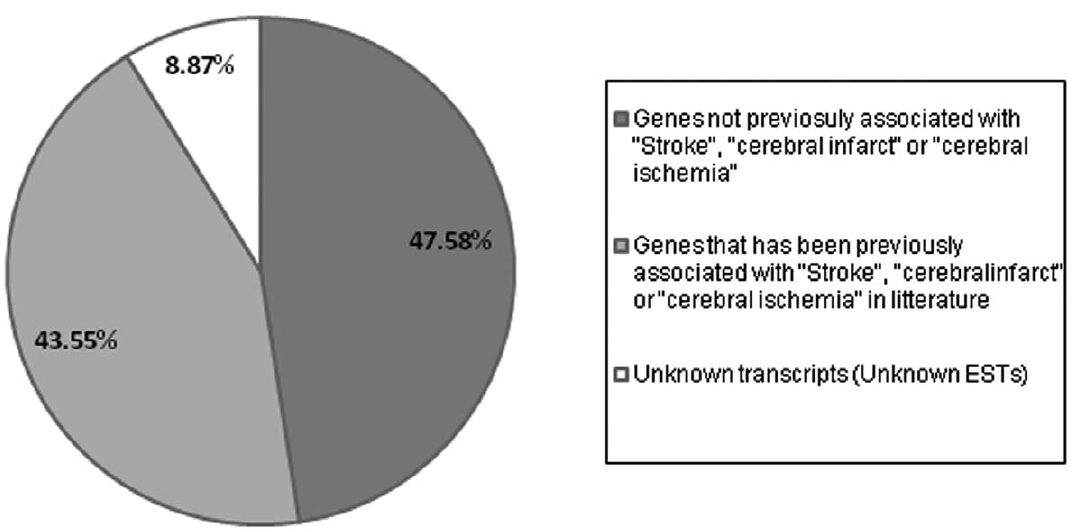
Figure 3. Microarray analysis leads to the identification of hundreds of genes not previously associated with stroke. Pie-chart showing the percentage of genes already associated with stroke or cerebral ischemia, the percentage of genes that were not associated, and the percentage of EST’s identified in this study. Percentages were calculated from a list of 300 genes selected by chance from the output of Venn diagrams and considering all the experimental conditions (24 h, 3 d, core and periinfarct). (EST: Expressed sequence tag).